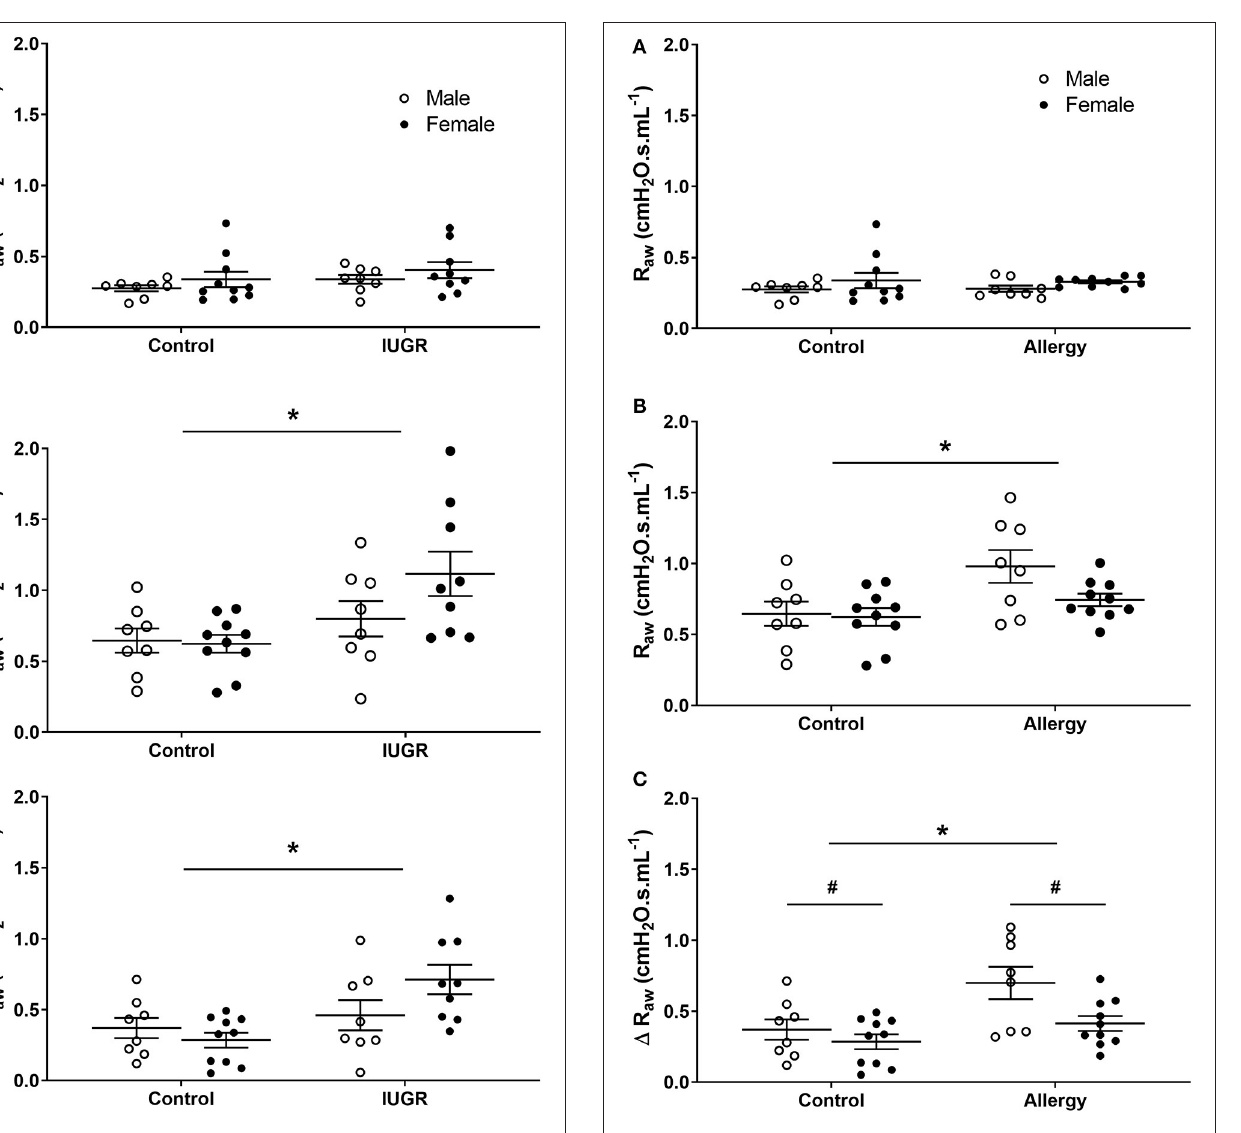
OVA IgE Levels Female offspring had higher OVA IgE levels than the